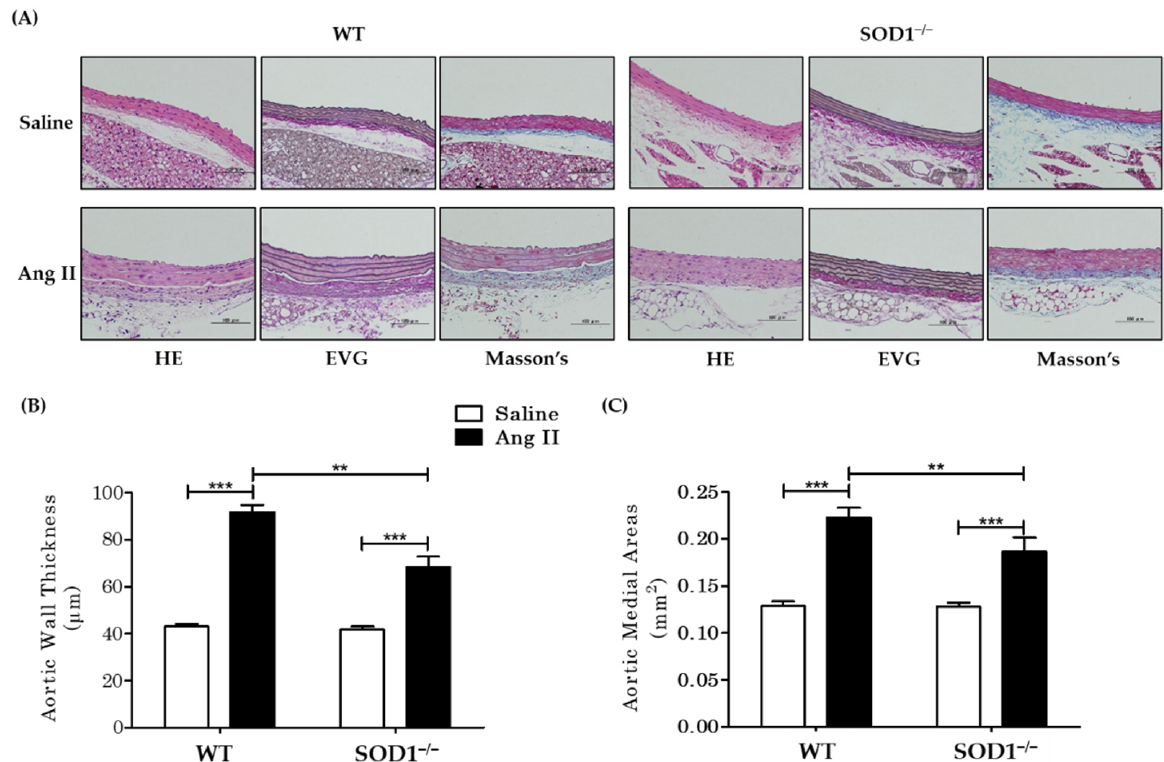
Figure 2. Microscopic appearance of aortas and quantitative analysis. ( A ) Hematoxylin–eosin (HE), Elastica van Gieson (EVG), and Masson’s staining of aortas. WT mice with saline (upper left), SOD1 − / − mice with saline (upper right), WT mice with AngII (lower left), SOD1 − / − mice with AngII (lower right). (Scale bar = 100 µ m.) ( B ) Quantification of aorta wall thickness and ( C ) medial areas measured by NIH Image software ( n = 10–12 per group. ** p < 0.01 *** p < 0.001) Error bars represent SEM. HE: Hematoxylin–Eosin Stain; EVG: Elastica van Gieson stain; Masson’s: Masson’s trichrome stain.